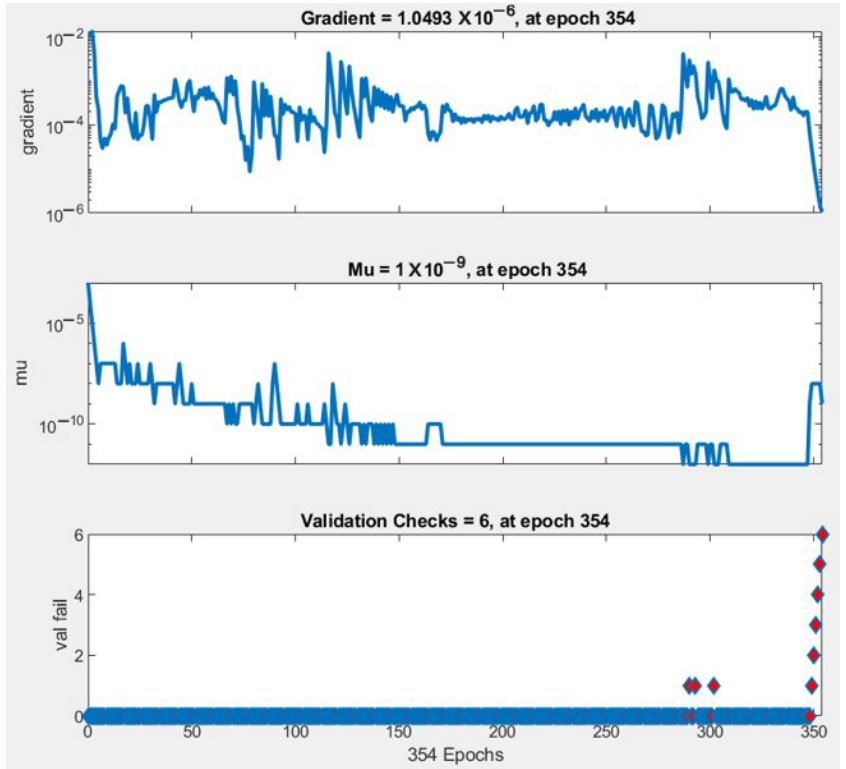
Figure 8. The relations between the number of epochs and the performance of the training state. The trained ANN-based model was evaluated based on RMSE, MAE, accuracy, sensi- tivity, specificity, precision, F-score, and G-mean, as shown in Table